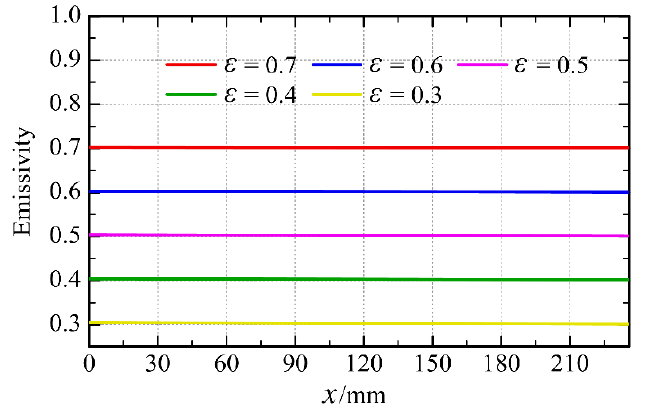
Figure 12. Corrected emissivity calculation results. The average value, maximum relative error, and average relative error of the corrected emissivity measurement results are shown in Table 3. Table 3. Average value and maximum and average relative errors of corrected emissivity.